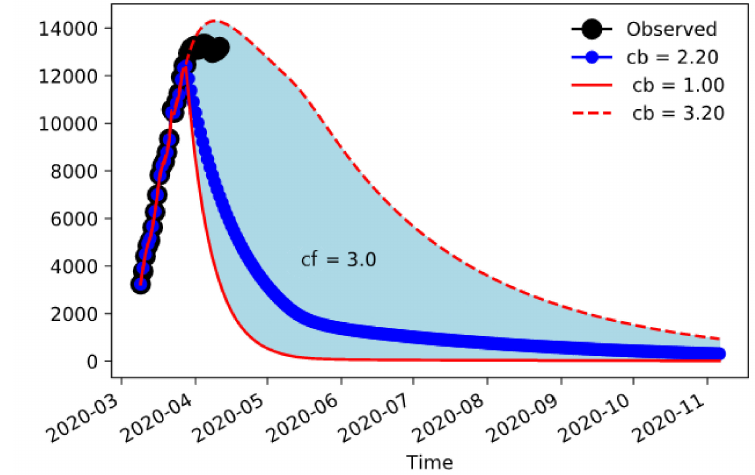
Figure 2. Number of COVID-19-associated hospitalizations in Lombardy according to the extended SEIR model. The black dots are observations, the red lines are the extrema of the ensemble, and the blue line is the center value. The envelope of the ensemble was calculated varying the minimum number of contacts reached by the containment measures from 1.0 to 3.2 in steps of 0.2. Nudging was performed until 15 days before 12